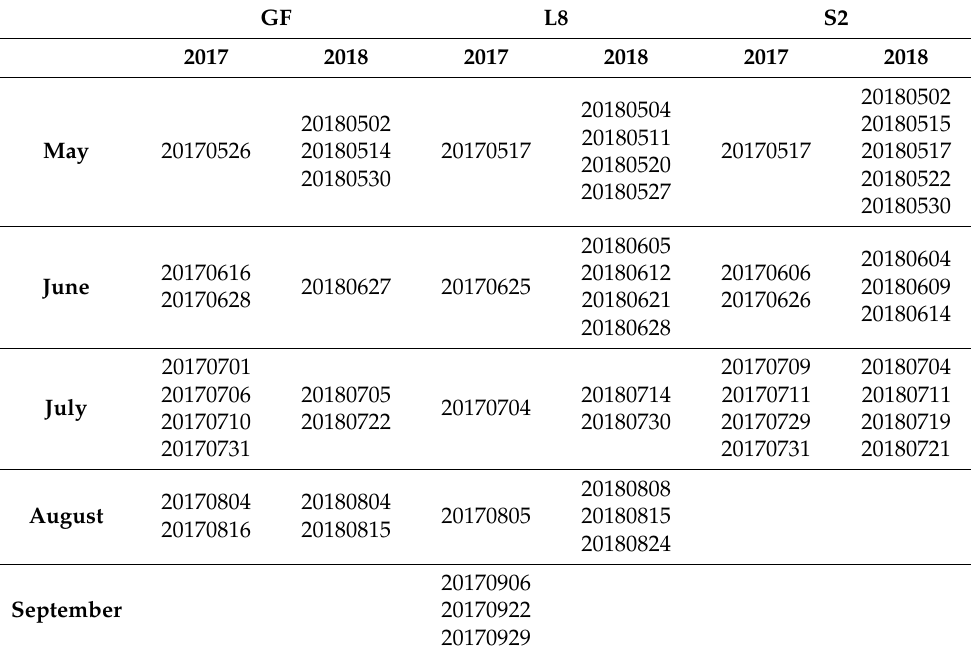
Table 2. The used satellites data from GF-1, S2 and L8. GF L8